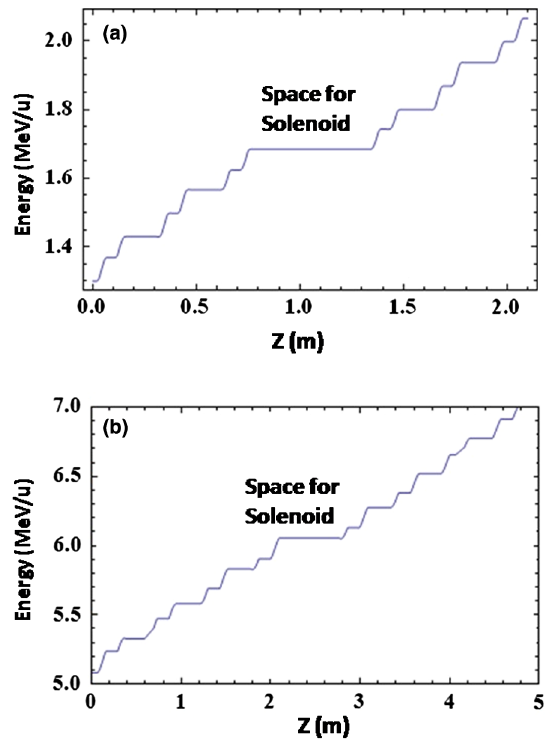
FIG. 5. Reference particle energy along z for (a) first focusing period consisting of six QWRs with gap for solenoid in between, and (b) last focusing period consisting of eight QWRs with gap for solenoid after fourth